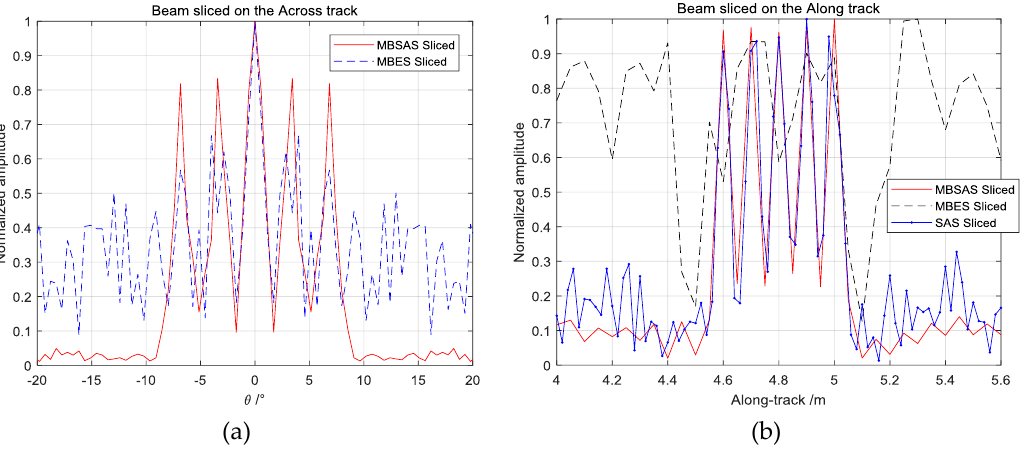
Figure 9. Comparison of sliced imaging output: resolution on ( a ) the across-track and ( b ) the along- track.